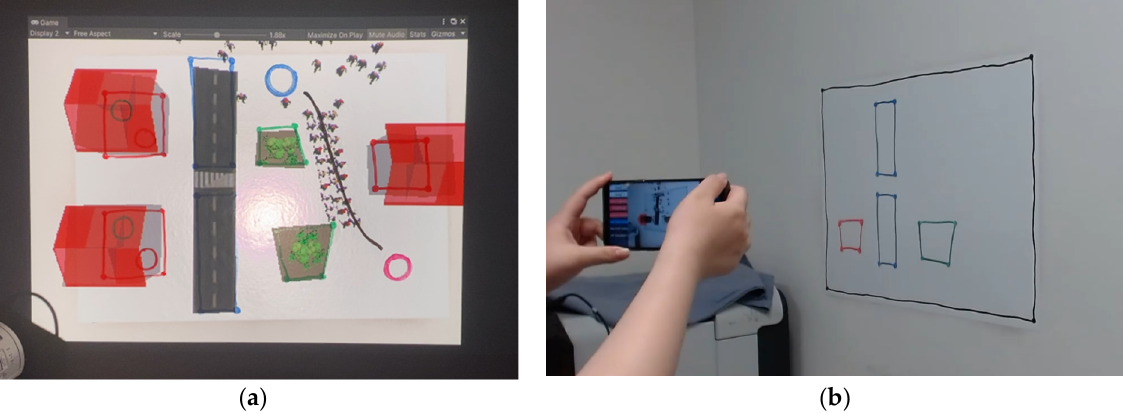
Figure 10. Visualization of the simulation results as: ( a ) projector-based AR visualization; ( b ) portable device-based AR visualization. Note that AR can overlay the CG objects over the sketches that user drawn on the board.